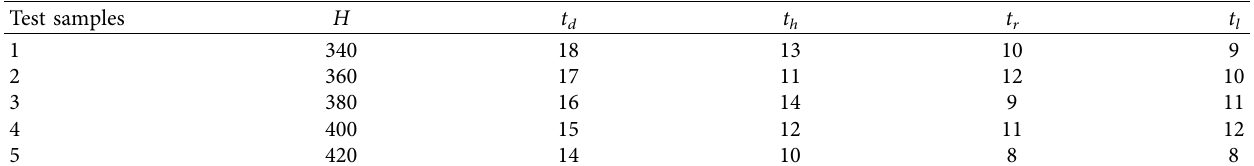
Table 3: Test samples (unit: